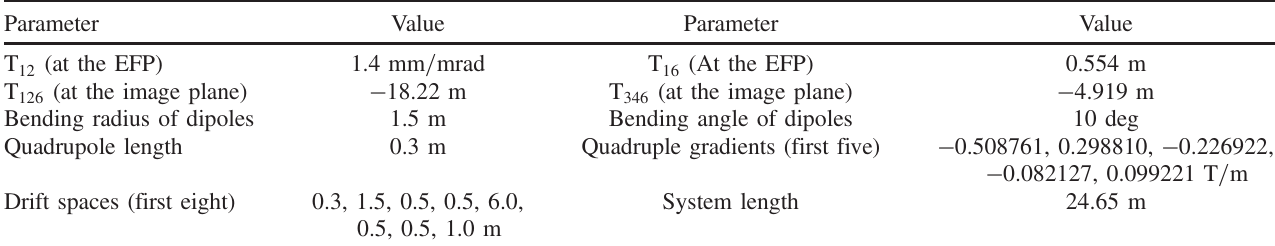
TABLE I. Parameters of the system shown in Fig. 3, expected for future validation.